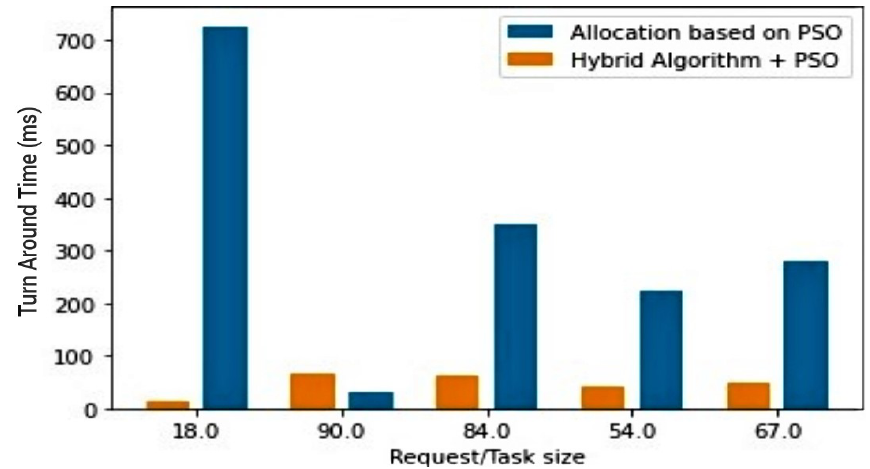
Figure 7. PSO vs. PSOR2B (Barchart).